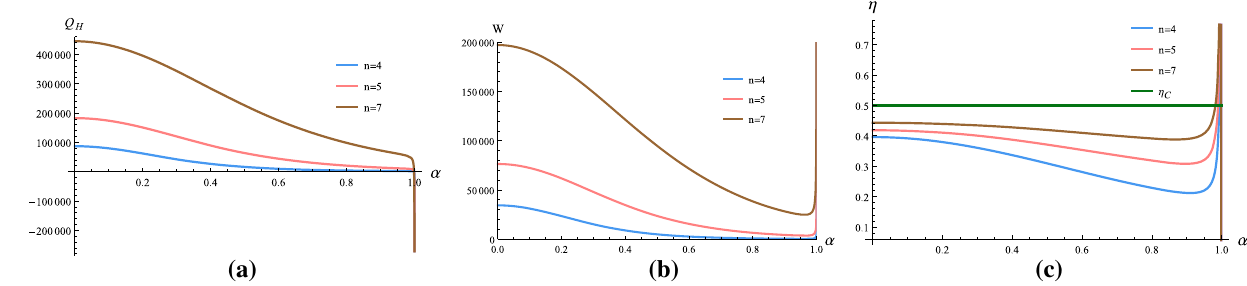
Fig. 15 In Jordan frame, plots for the net inflow of heat Q H , work done W and the efficiency η with respect to α (see the caption of Fig. 2 for parameter values)